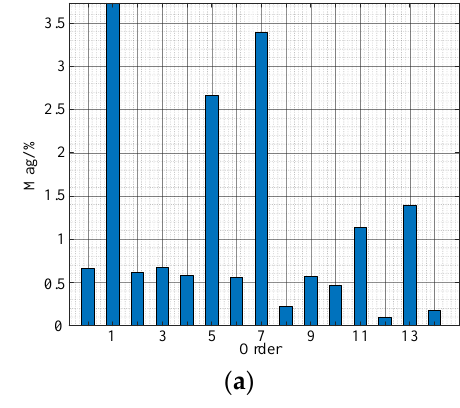
of (11); ( b ) G R ( s ) of (12).